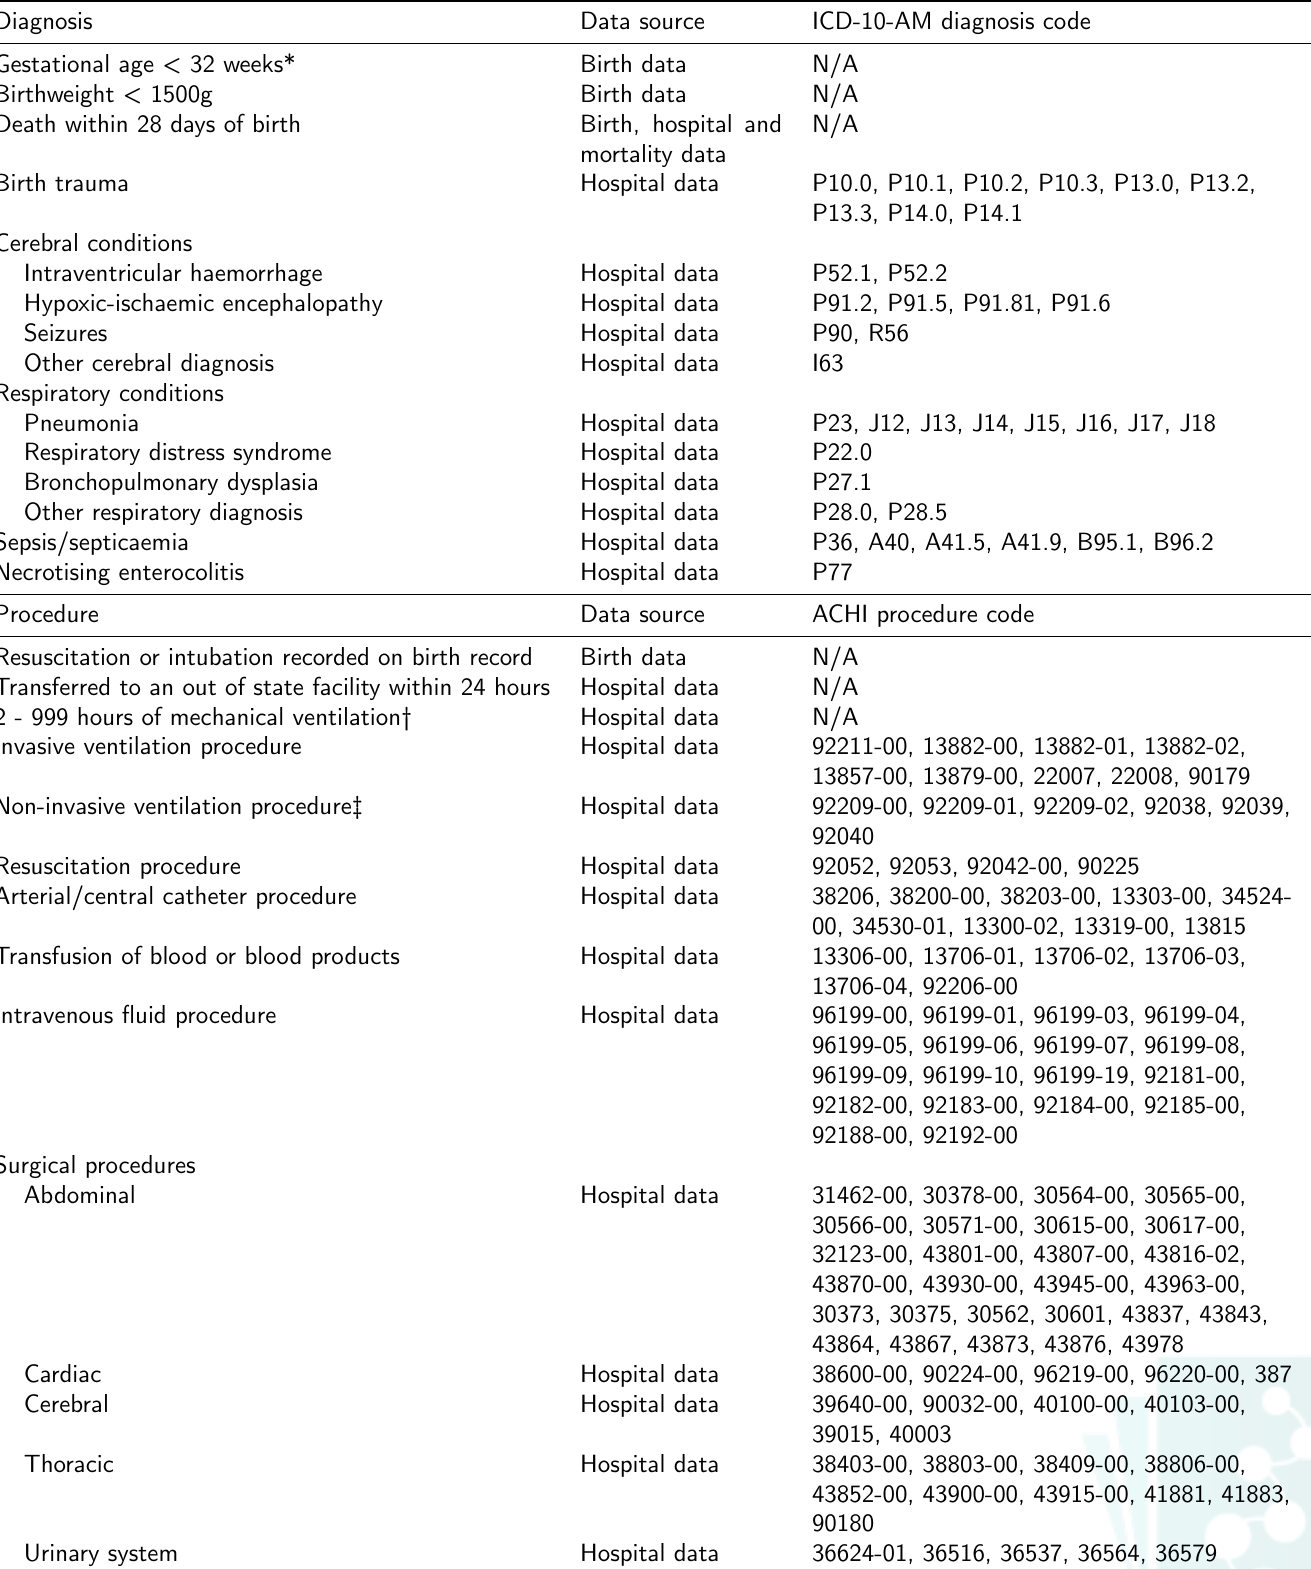
Table 1: Diagnosis and procedure indicator components for the updated neonatal adverse outcome indicator